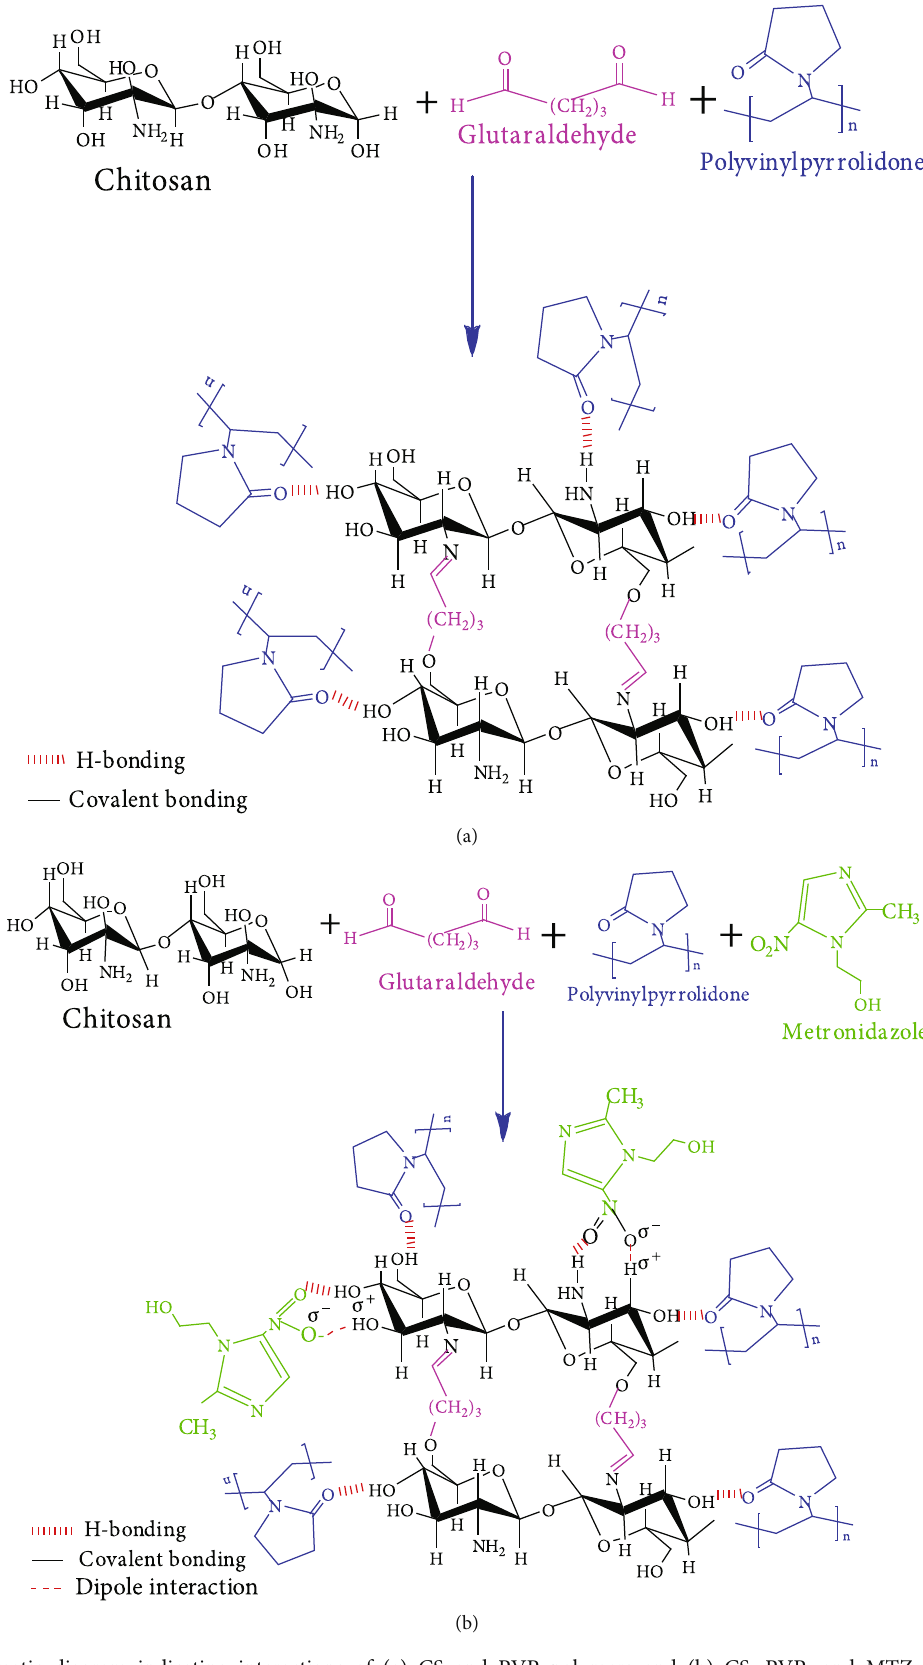
Scheme 1: Schematic diagram indicating interactions of (a) CS and PVP polymers and (b) CS, PVP, and MTZ via glutaraldehyde